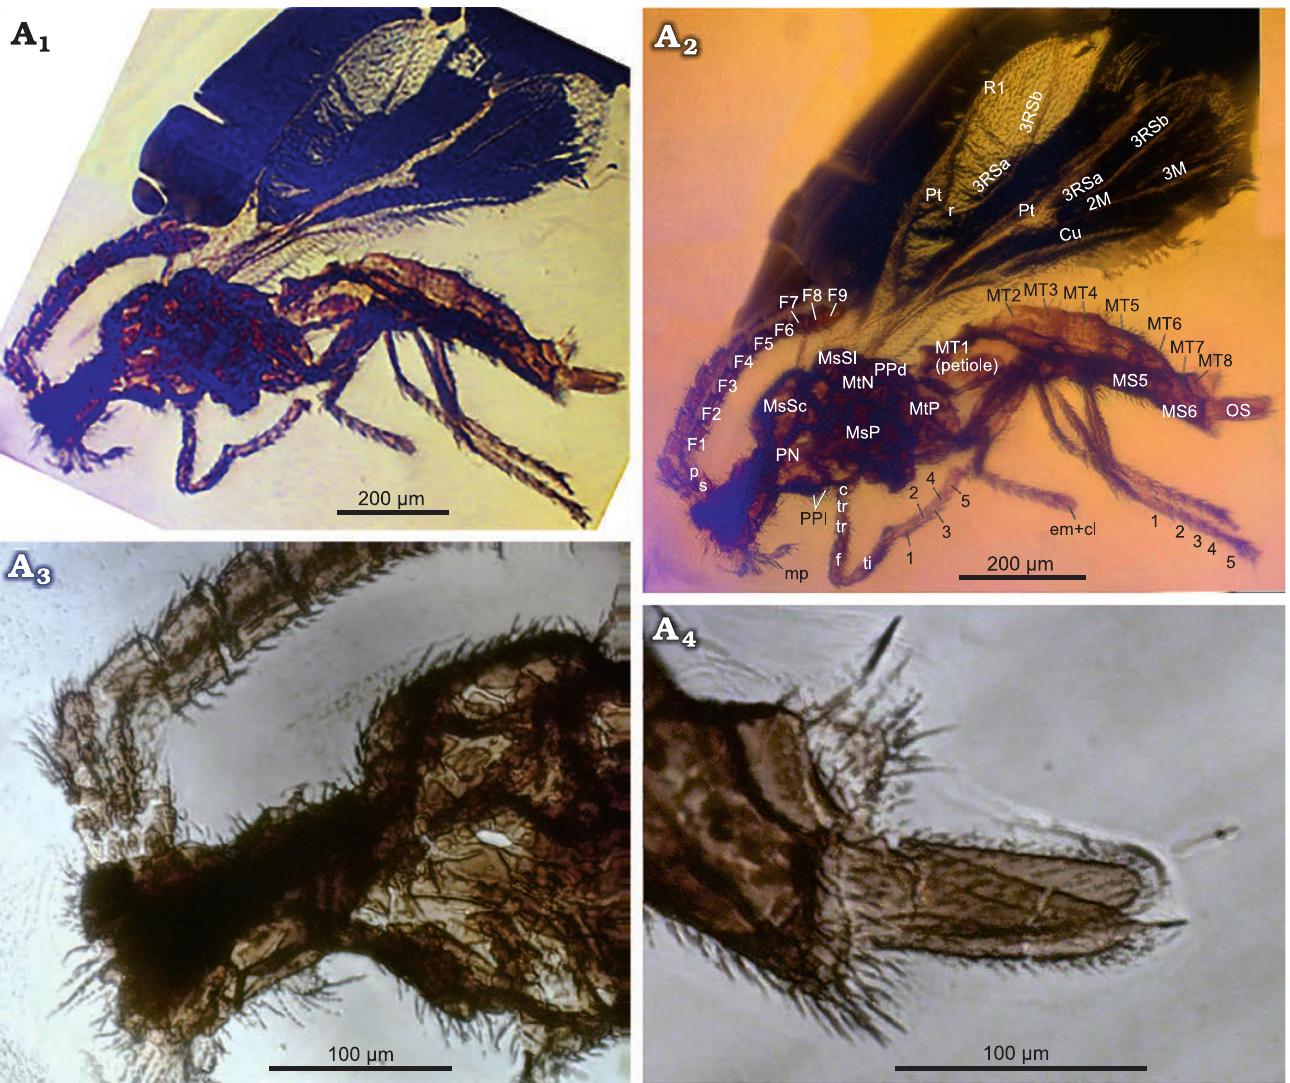
Fig. 1. Aphidiine wasp Ephedrus rasnitsyni Davidian and Kaliuzhna sp. nov., holotype PIN 3387/79, Starodubskoye, Sakhalinian amber (Russia), middle Eocene. Specimen in lateral view (A 1 ), explanatory morphology (A 2 ), anterolateral part of the specimen (A 3 ), ovipositor sheaths inlateral view (A 4 ). Abbreviations: body: c, coxa; em+cl, empodium and claws; f, femur; F1–F9, flagellomeres 1–9; mp, maxillary palp; MS5-6, metasomal sternites 5 and